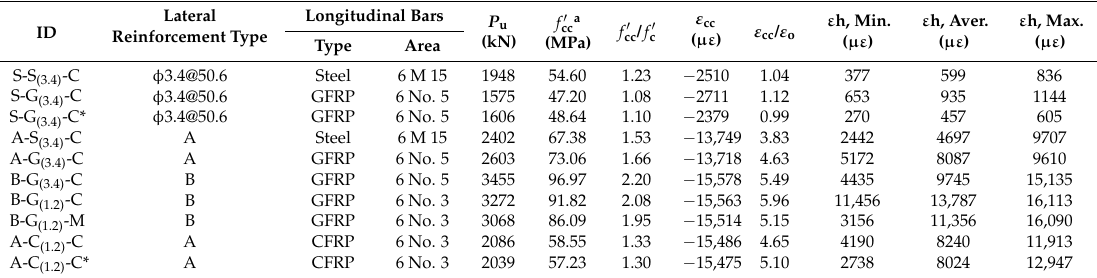
Table 2. Specimen’s details and test results.